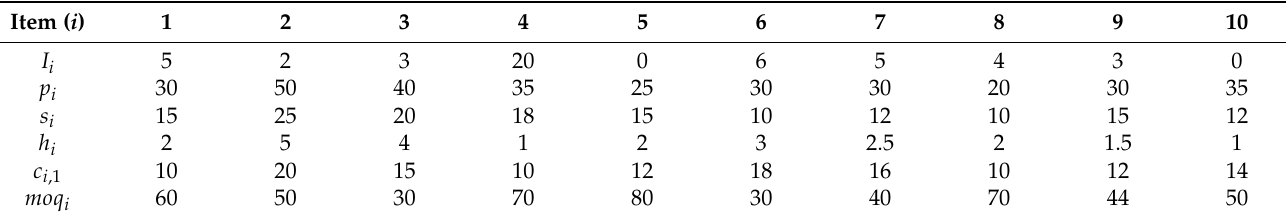
Table 3. Values of parameters of item i in Experiment I.